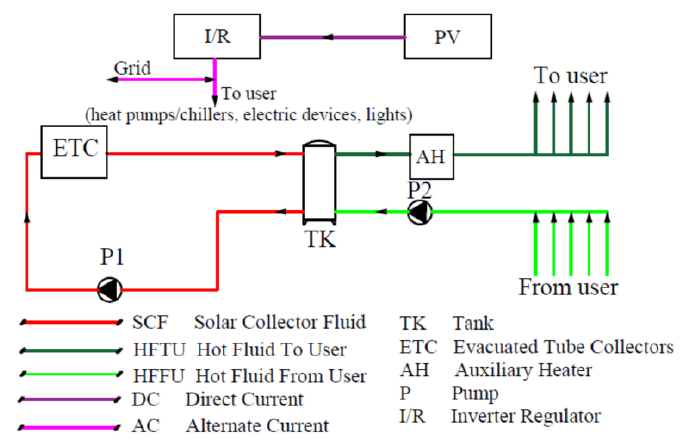
Figure 5. A hybrid district heating network [178].